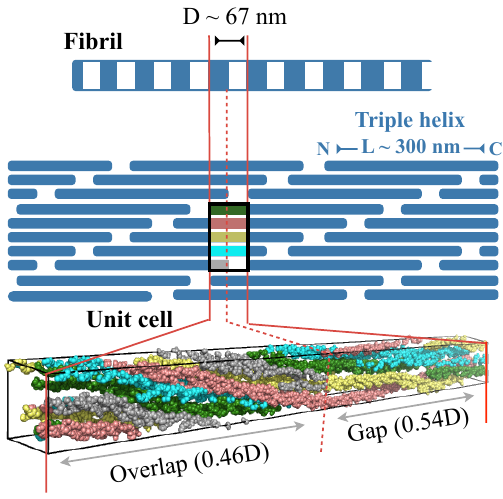
Figure 1. Structural hierarchy in Type I collagen fibril. The fibril is drawn at two different spatial resolutions, and a single unit cell or repeating unit of the fibril is also shown in molecular detail. The lower-resolution cartoon of the fibril depicts the repeating units (D-bands) containing low- and high-density regions, which emerge from the spatial arrangement of constituent triple helices (blue rectangles) in the fibril. The color scheme in the unit cell of the cartoon matches that in the unit cell showing molecular